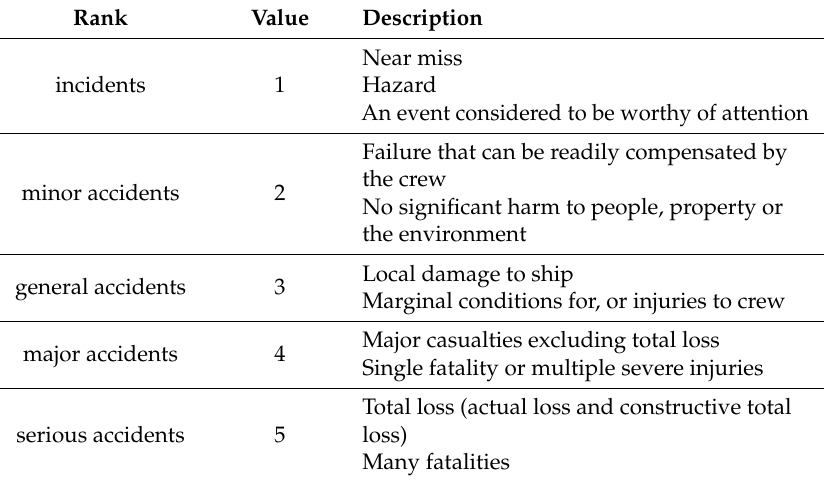
Table 3. Accident consequence score